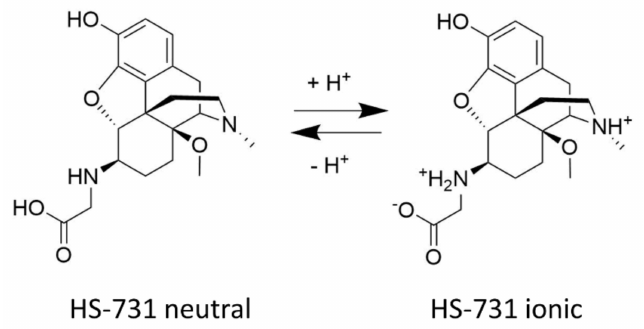
Figure 1. Structure of HS-731 and the acid-base equilibrium under physiological conditions. Table 1. In vitro binding affinities and agonist activities of HS-731 at the opioid receptors. Rat Opioid Receptor Human Opioid Receptor Receptor Binding affinity Binding affinity Functional activity K i (nM) K i (nM) EC 50 (nM) % stim. MOR 0.83 ± 0.02 a 0.90 ± 0.14